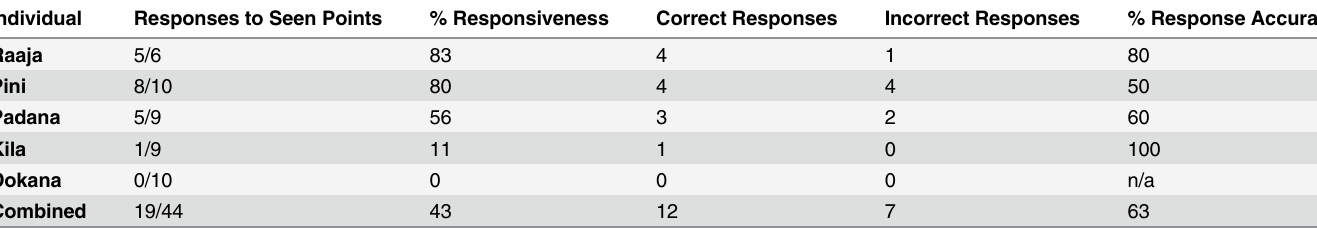
Table 1. Study 1: Individuals ’ Responsiveness to and Comprehension of Conspecific